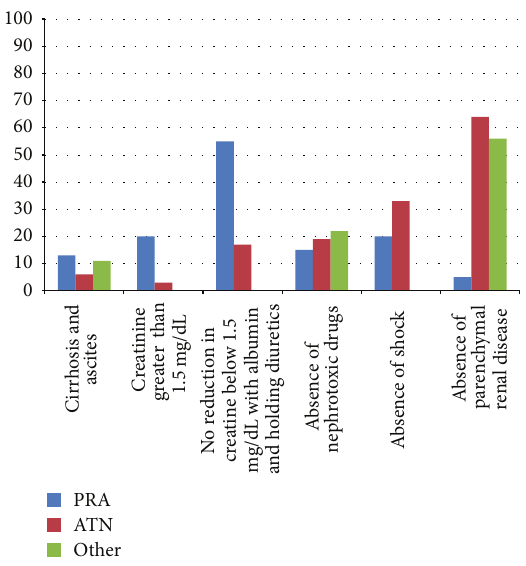
Figure 3: Percentage of participants with acute kidney injury who failedtosatisfyAscitesClubCriteriaforhepatorenalsyndrome.PRA (prerenal azotemia), ATN (acute tubular